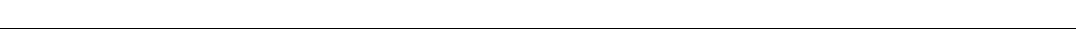
Fig. 2 Defects in mitochondrial structure and function in α -syn mutant hNs. a, b hiPSC-derived A53T hNs ( a ) and hESC-derived A53T and E46K hNs ( b ) have more highly fragmented mitochondria compared to corrected hNs and WT hNs respectively as shown by mitoDSRed expression; scale bar: 10 μ m. c Percentage of total hNs that have fragmented mitochondria. Data represent mean ± s.e.m. ** P < 0.01 by ANOVA followed by Tukey ’ s post hoc test, for hiPSCs, n = 12 coverslips, for hESCs, n = 6 coverslips from 3 independent differentiations, DIV: 60. d – f Transmission electron micrographs of hiPSC- derived corrected and A53T hNs ( d ) or hESC-derived WT, A53T and E46K hNs ( e ) show that mutant cells contain smaller mitochondria, with a lower average diameter ( f ), ** P < 0.01 by ANOVA followed by Tukey ’ s post hoc test, n = 6 independent cultures from 3 independent differentiations. g Micrographs of neurites from corrected (left panels) and A53T-mutant (right panels) hNs expressing mitoDSRed and labeled for α -syn phosphoserine 129 (PS129). Arrows show areas where PS129 colocalizes with MitoDSRed. Boolean operation was employed to pseudo-label regions of colocalization in blue. Boxes show high magni fi cation of the regions indicated. Scale bar: 10 μ m. h Quanti fi cation of hNs with α -syn PS129 on fragmented mitochondria. Data represent mean ± s.e.m. ** P < 0.0001 by t -test, n = 6, DIV: 60. i , j Proximity of Tom20 and α -syn as assessed by proximity ligation assay (PLA) ( i ) showed signi fi cantly more α -syn within 40 nm of the OMM in A53T relative to corrected hNs ( j ). ** P = 0.0055 by Student's t -test, n = 6 coverslips from 3 independent differentiations, DIV: 60, scale bar: 10 μ